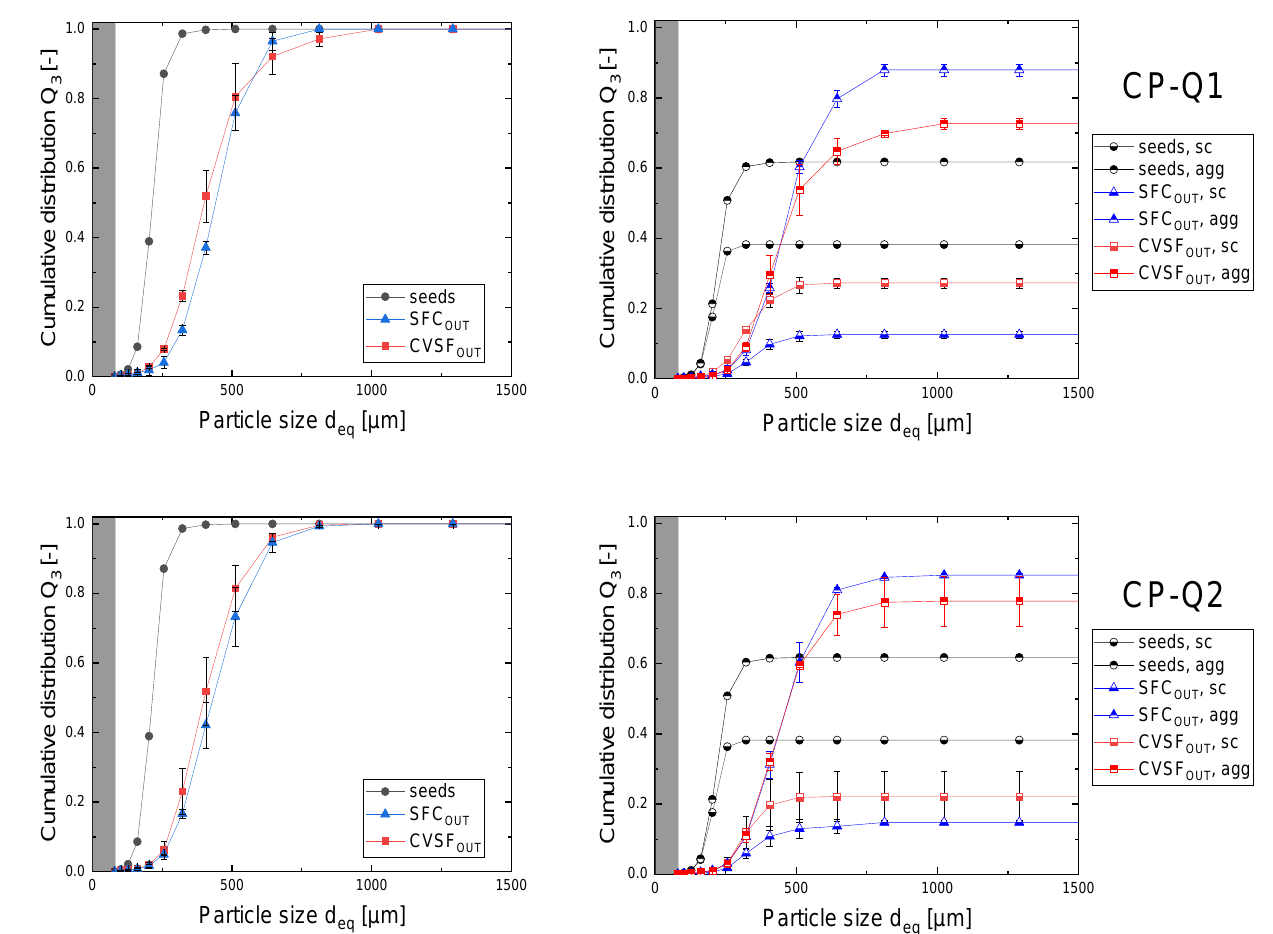
Figure 7. Overall PSDs (left) and corresponding subpopulations of single crystals (sc) and non-single crystals (agg). The upper diagrams show the PSDs for the experiments CP-Q1 and the lower for the experiments CP-Q2. The grey area shows the analyzation limit for particle classification of 80.6 µm [30]. Operating conditions as shown in Table 1. Results of the individual experiments are is shown in Table S2.